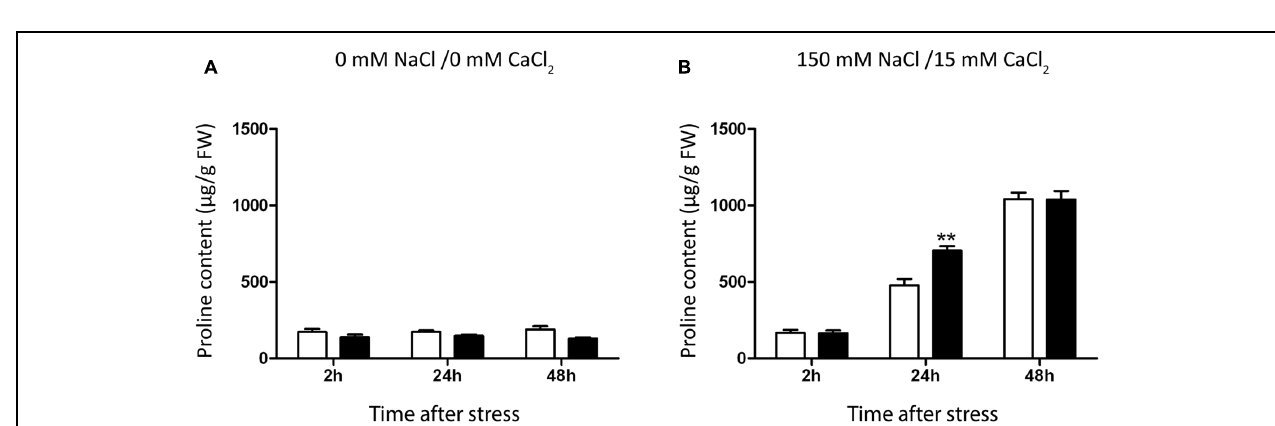
last periods of the experiment, cm 2 /d. (C,D) Percentage of non-green area of non-inoculated (C) and inoculated (D) plant rosettes under the experimental condition described. Data are means ± 1 SE of at least eight plants per treatment. Asterisks indicate significant differences between control and PsJN treatment in each time point ( t -student, p < 0.05; Welch’s correction, ∗ P < 0.1; ∗∗ P < 0.05; ∗∗∗ P < 0.01). Whitebars in photograph correspond to 2 cm.